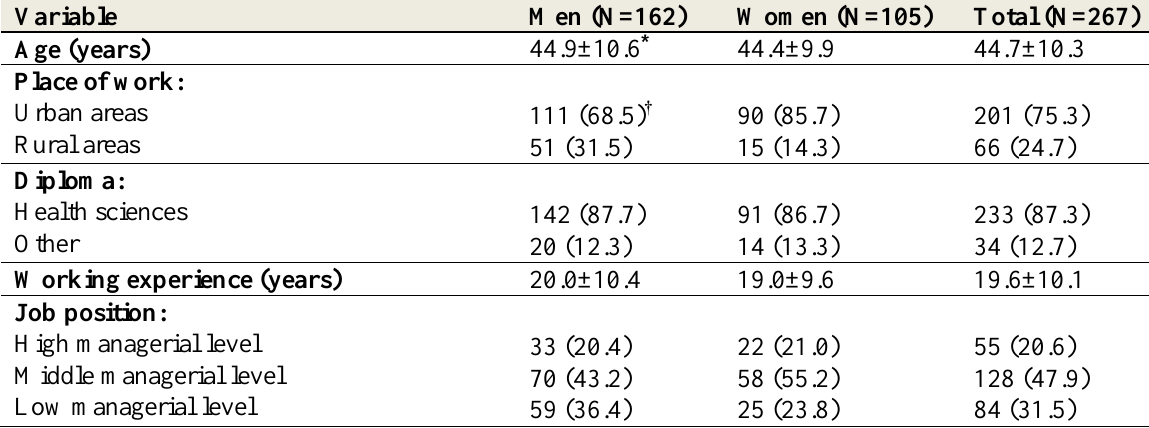
Table 1. Baseline characteristics in a nationwide representative sample of health professionals